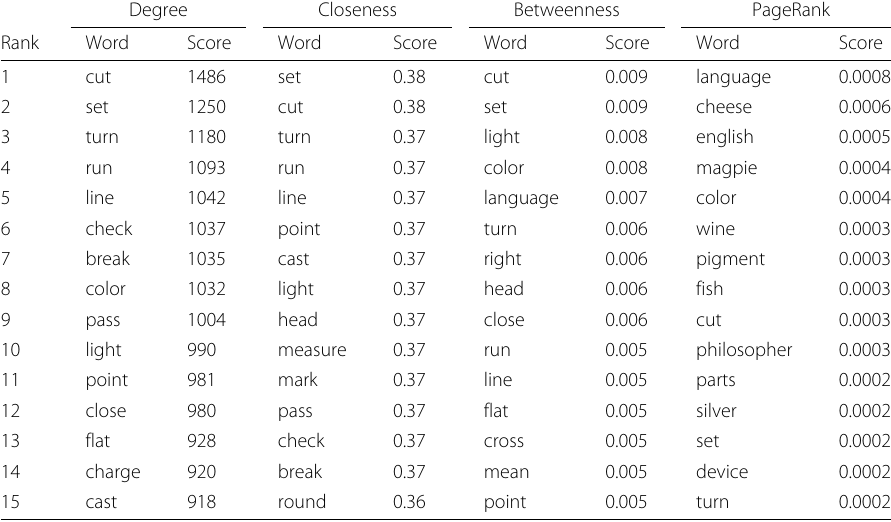
Table 4 The most central nodes (words) in the Moby Thesaurus network according to four classic centrality measures: degree, closeness, betweenness, and